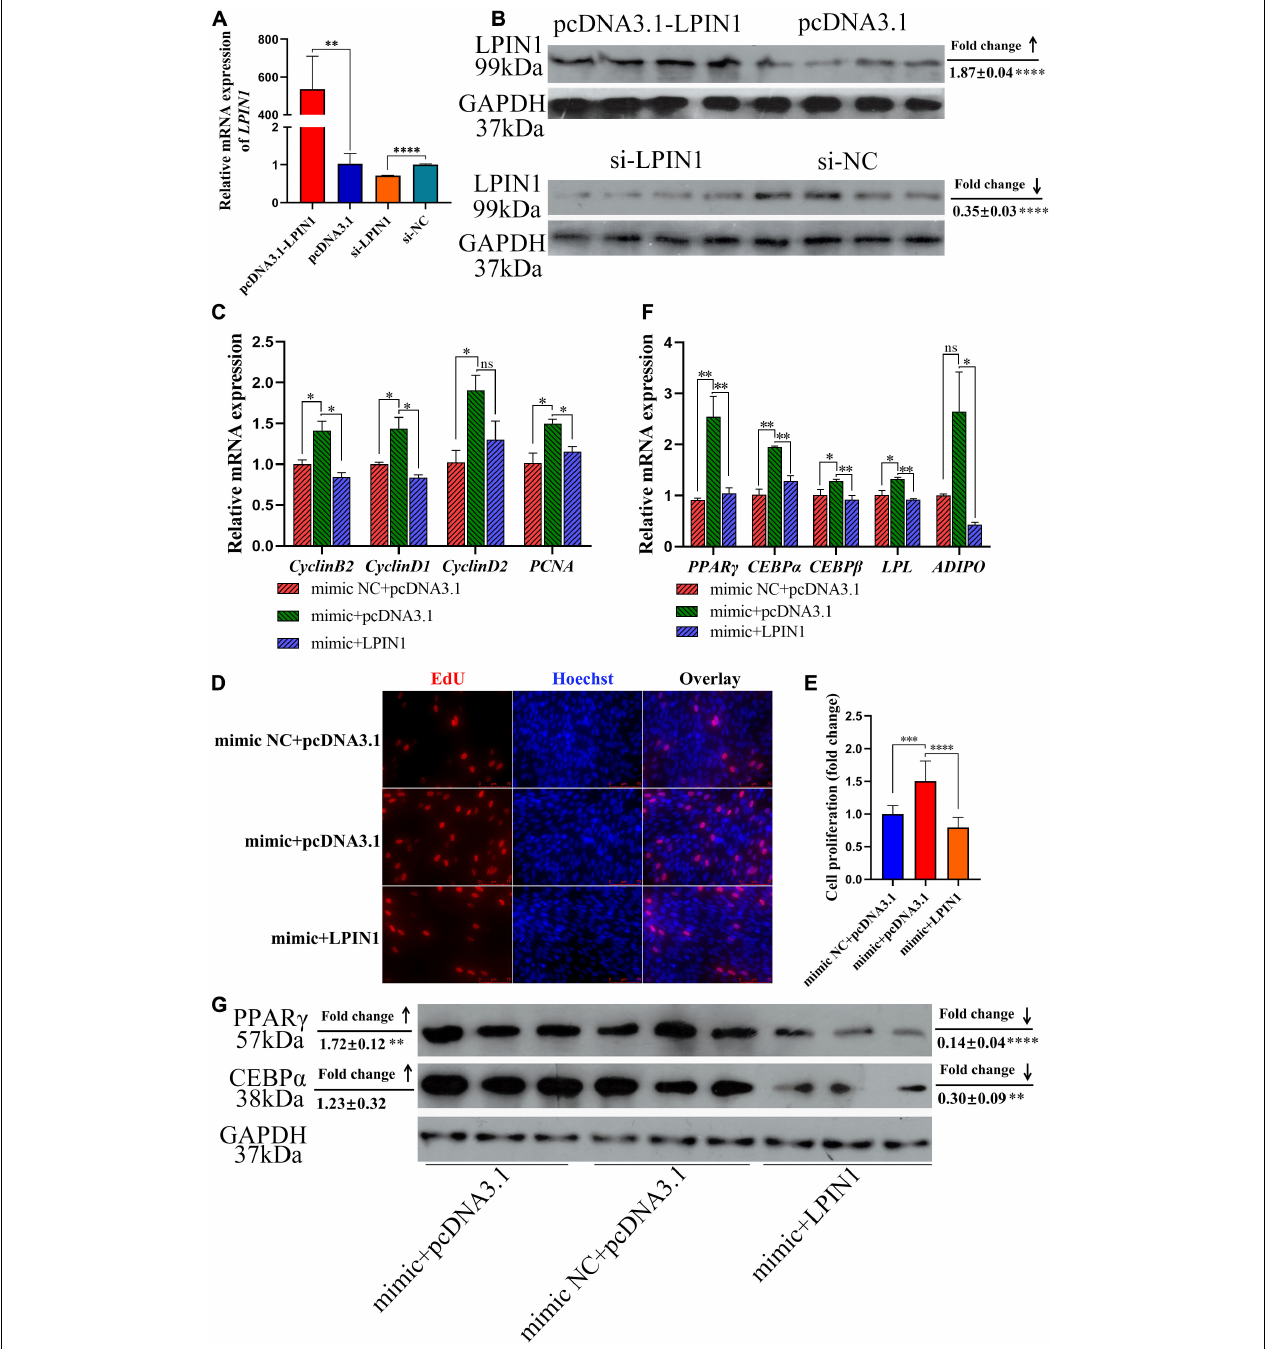
FIGURE 7 | LPIN1 plays a pivotal role on preadipocytes proliferation and differentiation regulated by miR-429-3p. (A) Transfection efficiency of pcDNA3.1-LPIN1 and si-LPIN1 on mRNA level. (B) Transfection efficiency of pcDNA3.1-LPIN1 and si-LPIN1 on protein level. (C) The mRNA expression of cell cycle-promoting genes in ICP-1 treated with mimic NC + pcDNA3.1, mimic + pcDNA3.1, and mimic + pcDNA3.1-LPIN1. (D) The mRNA expression of preadipocyte differentiation-related genes in ICP-1 treated with mimic NC + pcDNA3.1, mimic + pcDNA3.1, and mimic + pcDNA3.1-LPIN1. (E,F) EdU assay performed in ICP-1 treated with mimic NC + pcDNA3.1, mimic + pcDNA3.1, and mimic + pcDNA3.1-LPIN1. (G) The protein expression of PPAR γ and C/EBP α in ICP-1 treated with mimic NC + pcDNA3.1, mimic + pcDNA3.1 and mimic + pcDNA3.1-LPIN1. Data presented as mean ± SEM, * P < 0.05; ** P < 0.01; *** P < 0.001; **** P < 0.0001; ns: no